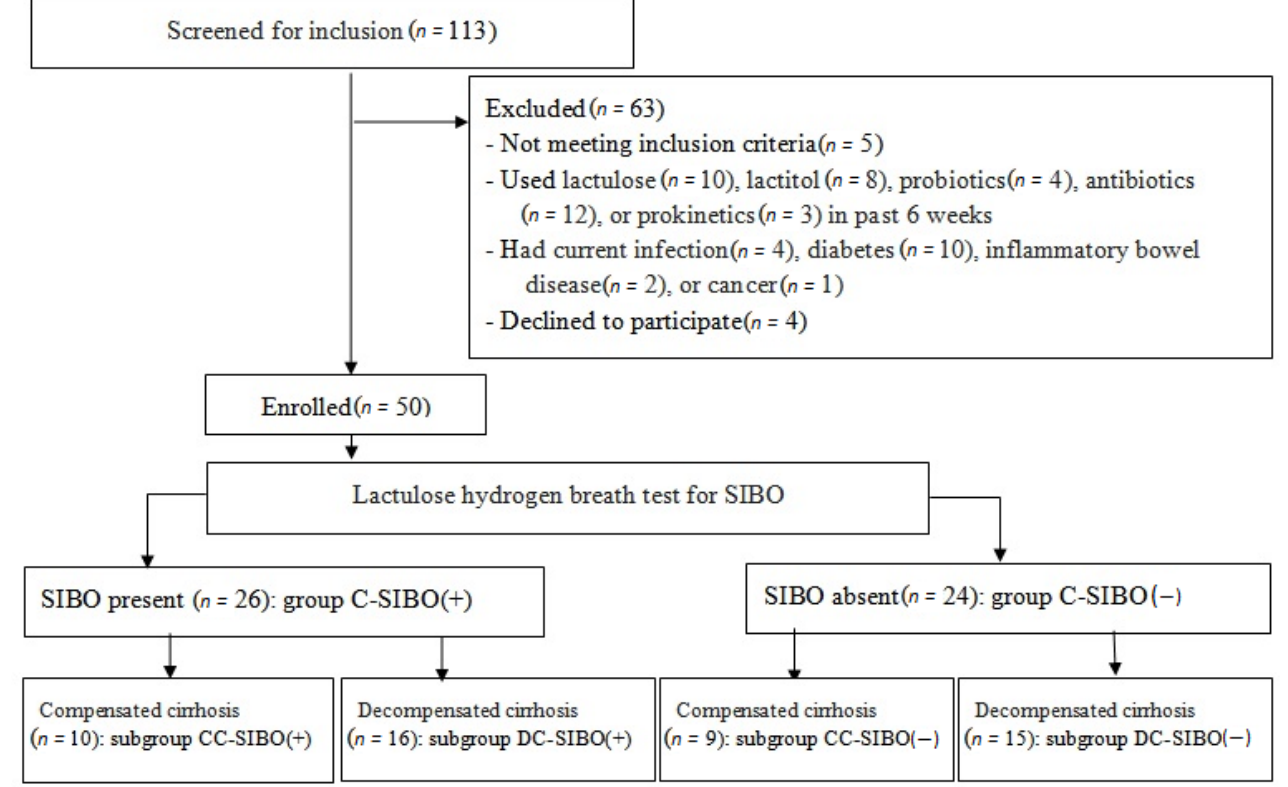
Figure 1. CONSORT 2010 flow diagram.